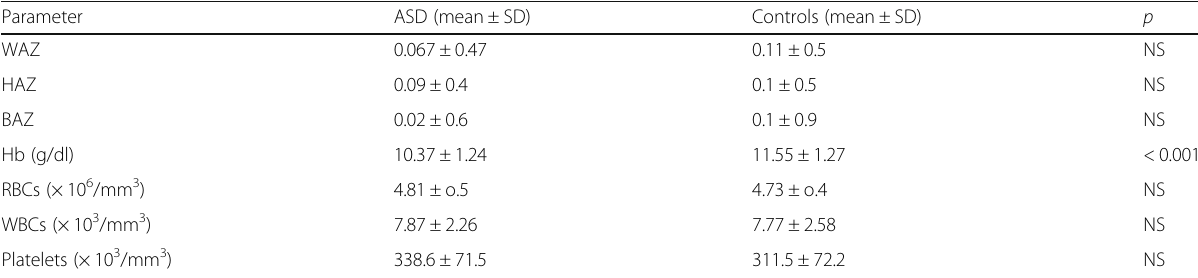
WAZ weight-for-age Z-score, HAZ height-for-age Z-score, BMI body mass index, Hb hemoglobin, RBCs red blood cell count, WBCs white blood cell count, NS non-significant